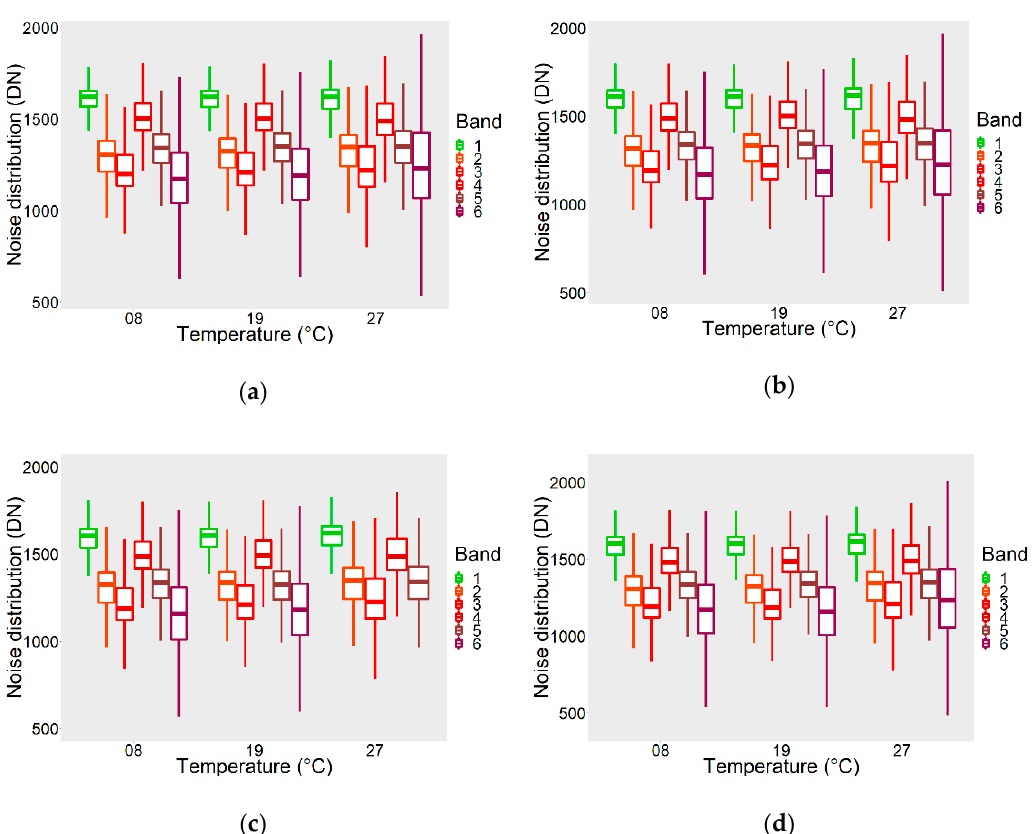
Figure 11. Comparison of the per-pixel noise distribution of dark offset images in the laboratory experiment: ( a ) Exposure time 50 µ S; ( b ) Exposure time 250 µ S; ( c ) Exposure time 500 µ S; ( d ) Exposure time 1000 µ S.